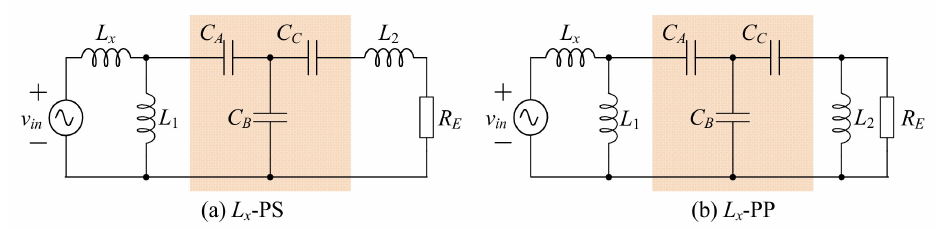
Figure 5. L x -PS and L x -PP CPT